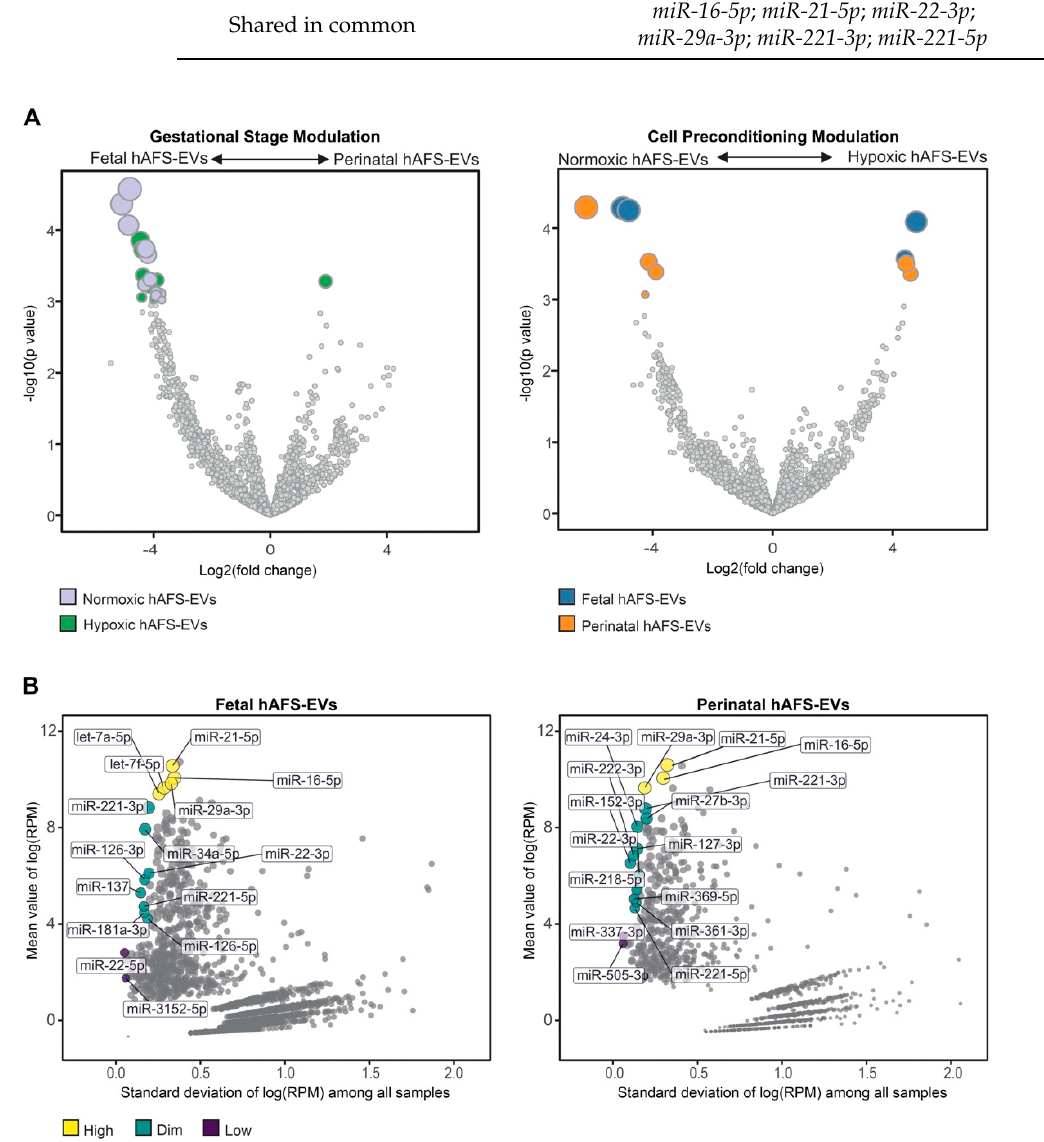
Figure 9. Analysis of differential enrichment of miRNAs in fetal- and perinatal hAFS-EVs. ( A ) Volcano plots for differential enrichment of hAFS-EV miRNA cargo according to gestational stage (left panel) and in vitro hypoxic preconditioning of secreting cells (right panel). For miRNA details, please refer to Table 1. ( B ) Scatter plot of the correlation between variability (X axis) and enrichment level (Y axis) of stable miRNAs within fetal hAFS-EVs (left panel) and perinatal hAFS-EVs (right panel) according to high (yellow dots), dim (green dots) and low (dark purple dots) enrichment. For miRNA details, please refer to Table 2. RPM: reads per million.